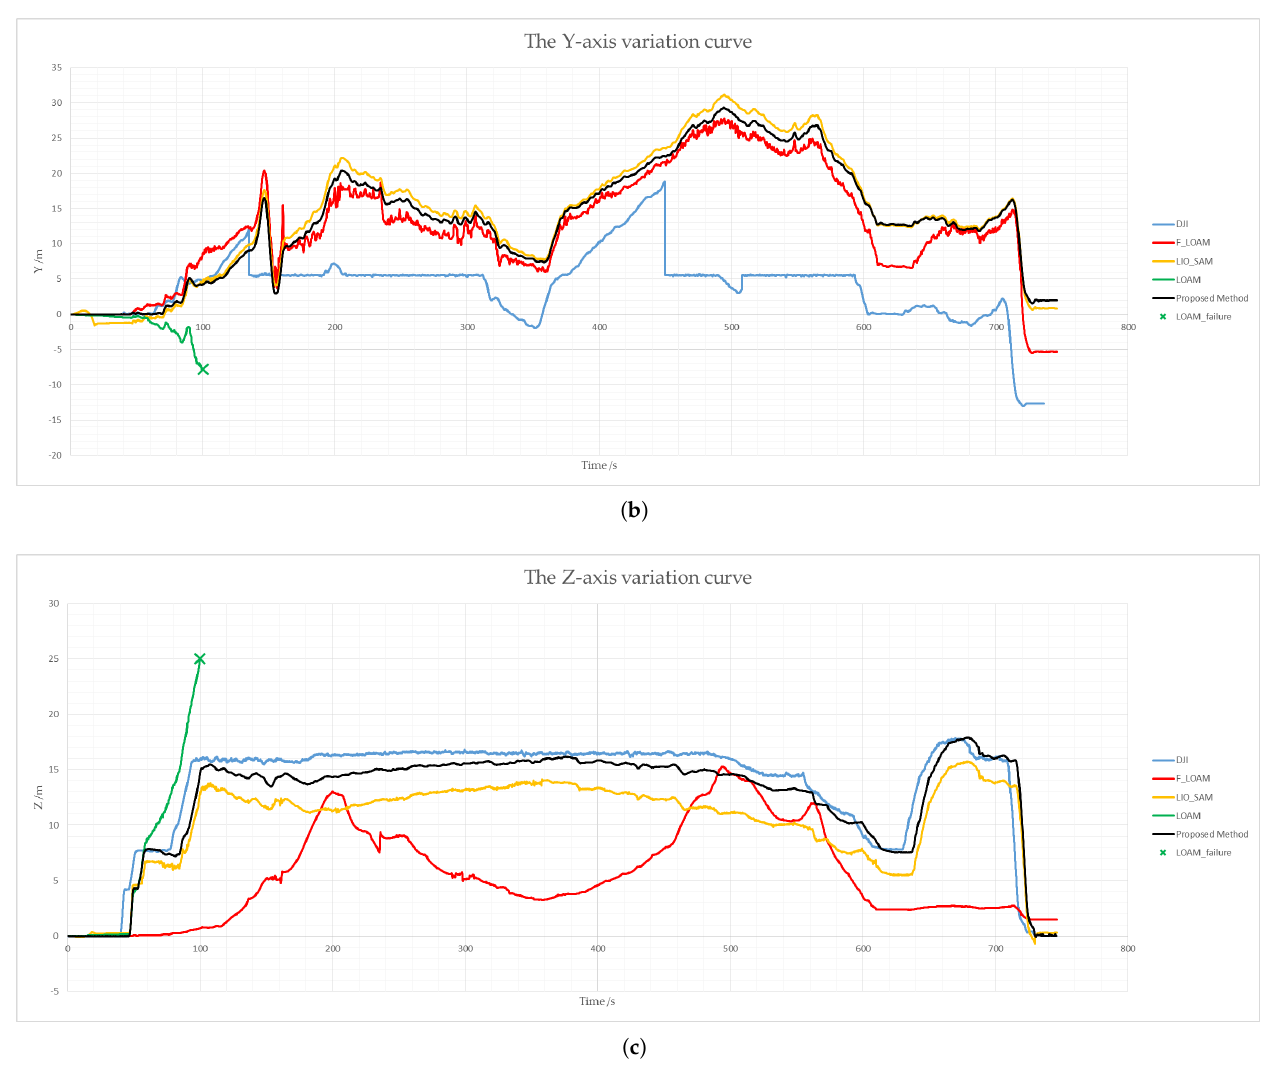
Figure 10. The x-axis, y-axis, and z-axis variation curves of the UAV’s flight trajectory. ( a – c ) are x-axis, y-axis, and z-axis variation curves with time,